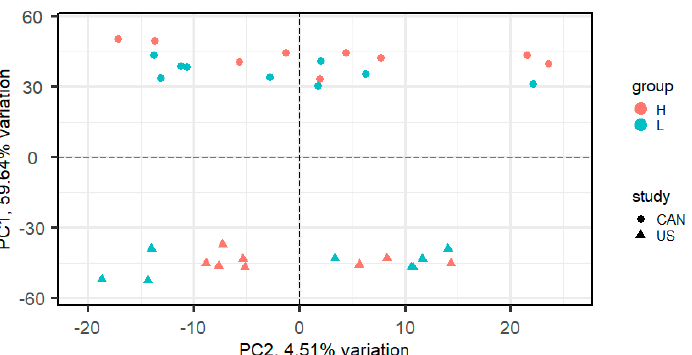
Figure 1. Principal component analysis (PCA) plot of normalized gene expression values in steers with high and low residual feed intake from a combination of a Canadian population and a United States population.